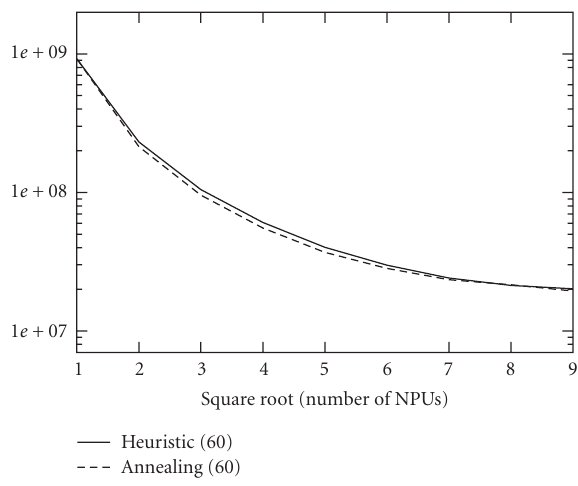
Figure 13: Objective function values (left y -axis)on a 6 × 6 NPU array and ratio in percent (right y -axis).